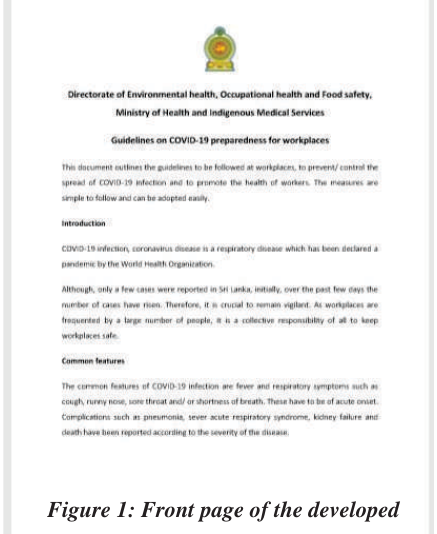
Figure 1: Front page of the developed